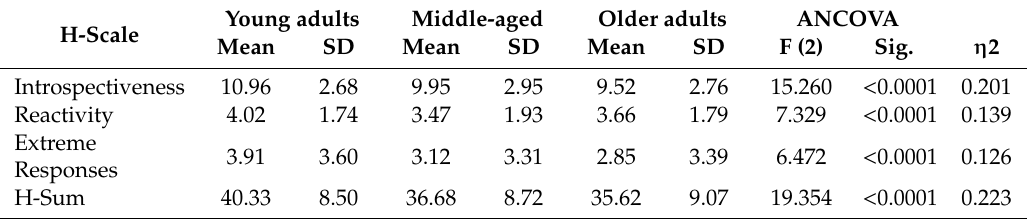
Table 4. Age di ff erences in